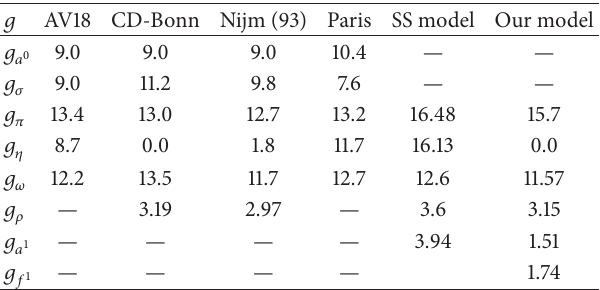
Table 3: The values of different effective meson-nucleon couplings inthephenomenologicalinteractionmodels[56],SSmodel[18],and our